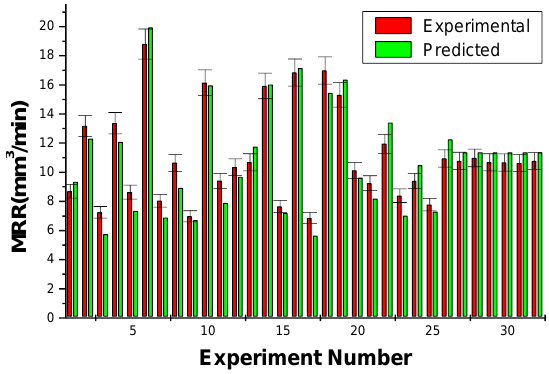
Figure 3. A comparative studies of experimental data and MRR model estimates during the GAEDD